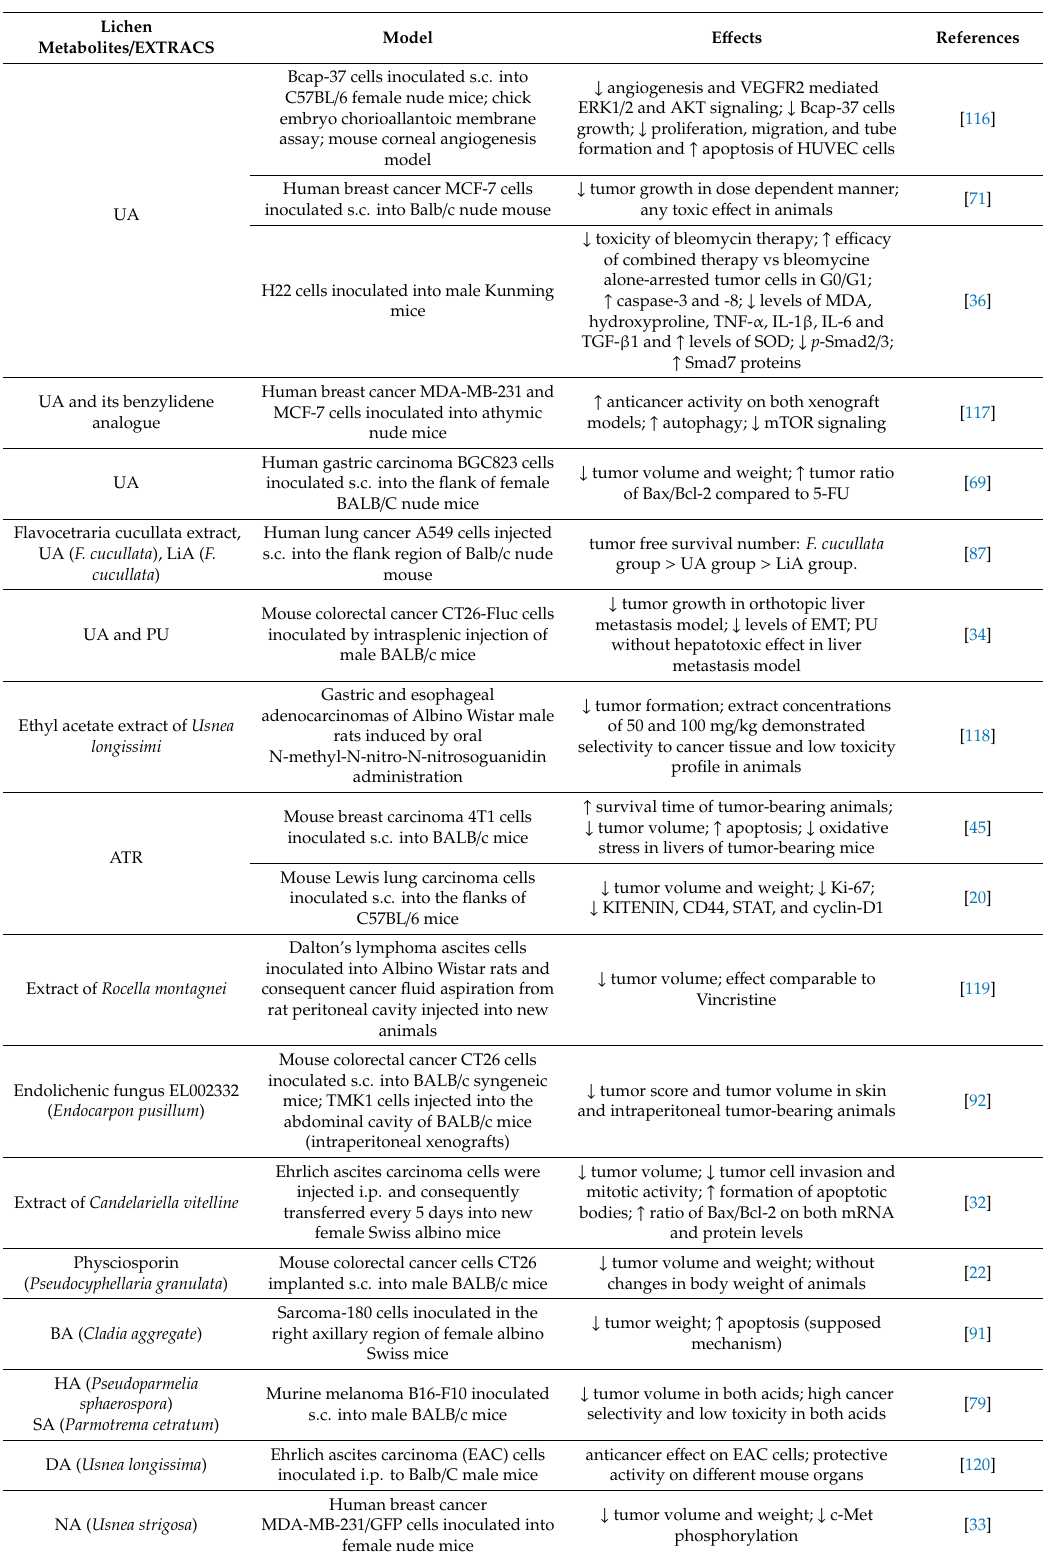
Table 5. In vivo studies dealing with anticancer e ff ects of extracts or isolated secondary metabolites of